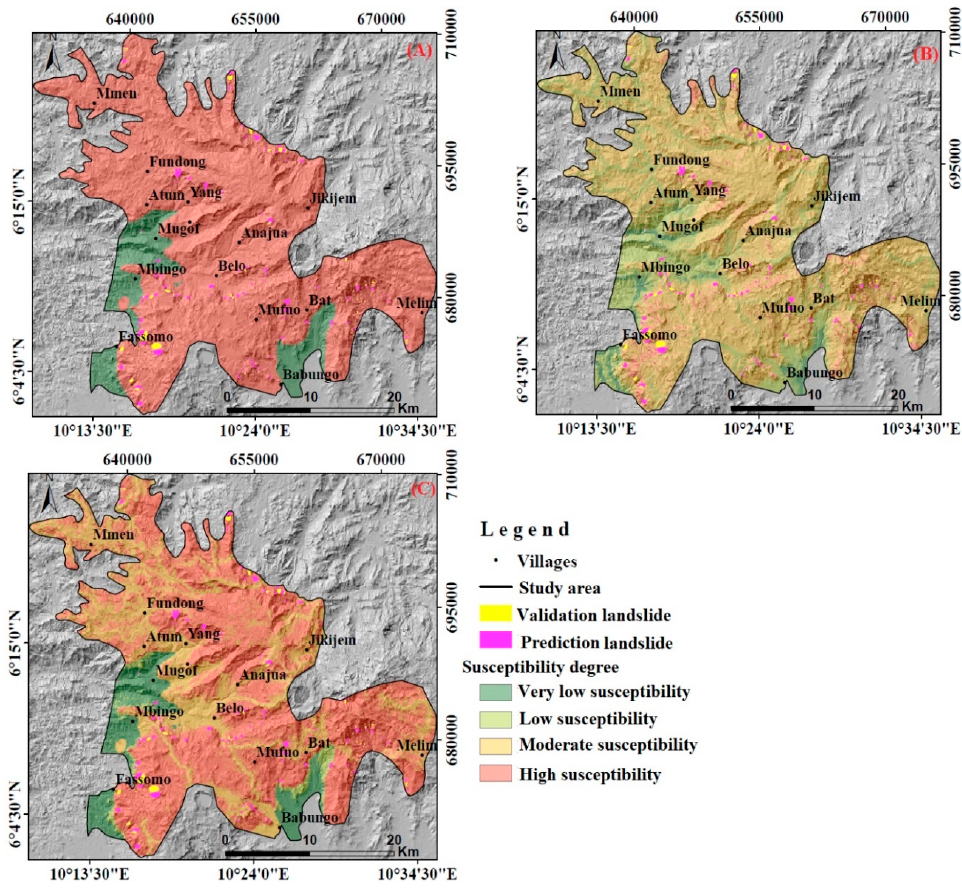
Figure 10. The landslide-susceptibility models classified into four classes: ( A ) Soil properties; ( B ) geo- environmental factors; ( C ) soil properties merged with geo-environmental factors. geo-environmental factors; ( C ) soil properties merged with geo-environmental